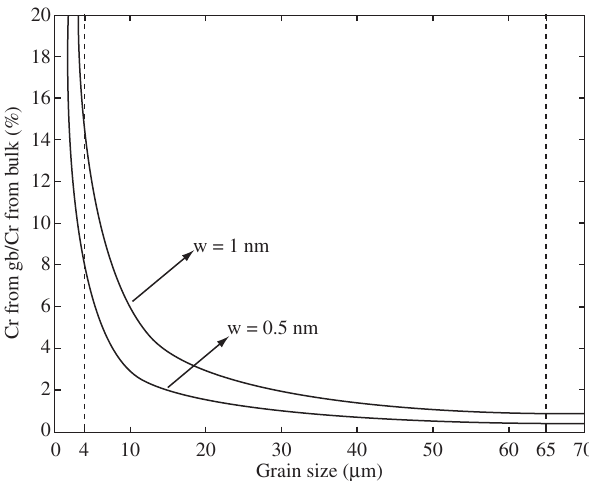
O scale growth on the 2 3